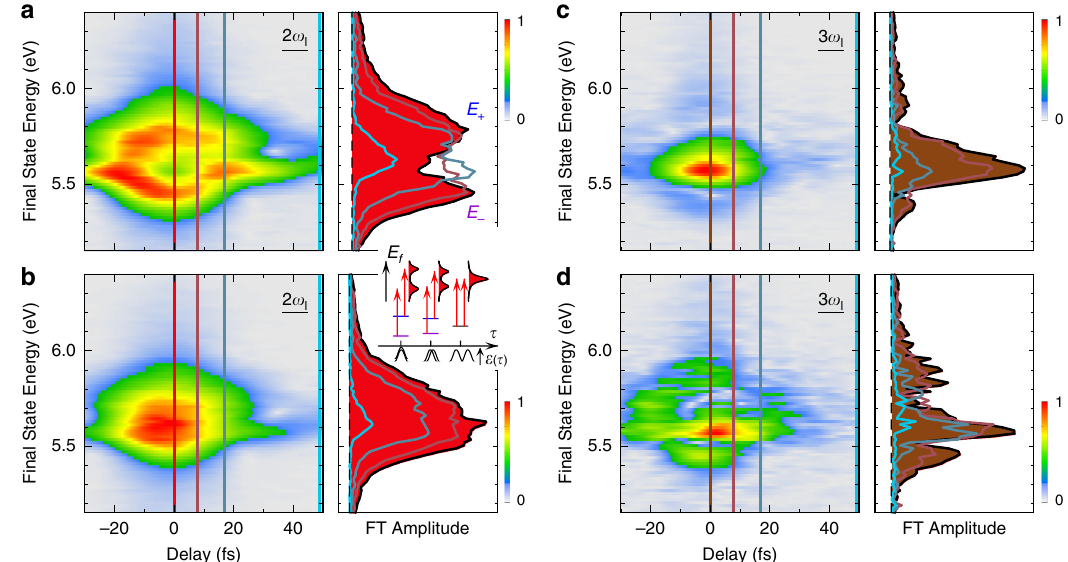
Fig. 2 Femtosecond E ( τ ) fi eld undressing of the surface bands. IFT spectra of the 2 ω l - a , b and 3 ω l -polarization c , d responses at k || = 0 Å − 1 for excitation with high (top) and low (bottom) optical fl uence. At high fl uence and τ = 0 fs, in a and c , the AT doublet and the MT triplet structures are visible, respectively. As the instantaneous E ( τ ) decreases with increasing τ ; however, the dressed bands converge to undressed ones within ~15 fs (cf. inset). At low fl uence, E ( τ ) is suf fi cient to drive the 4PP process, but its dressing is minimal. Energy line pro fi les taken for selected delay points (color coded) are shown for each measurement in the right. The inset shows how the dressing depends on the instantaneous excitation fi elds, as τ is